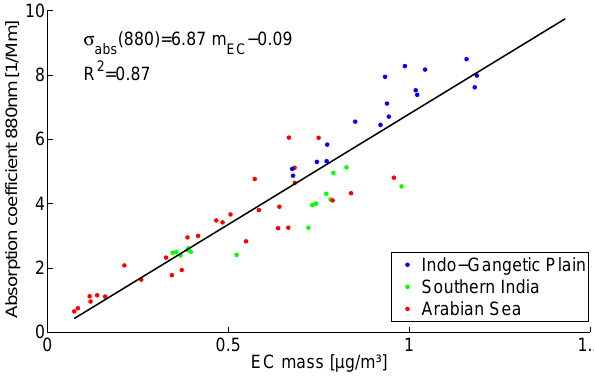
Figure 9. Particle absorption coefficient for 880nm against PM 2 . 5 EC mass concentration, grouped by source regions according to Fig.